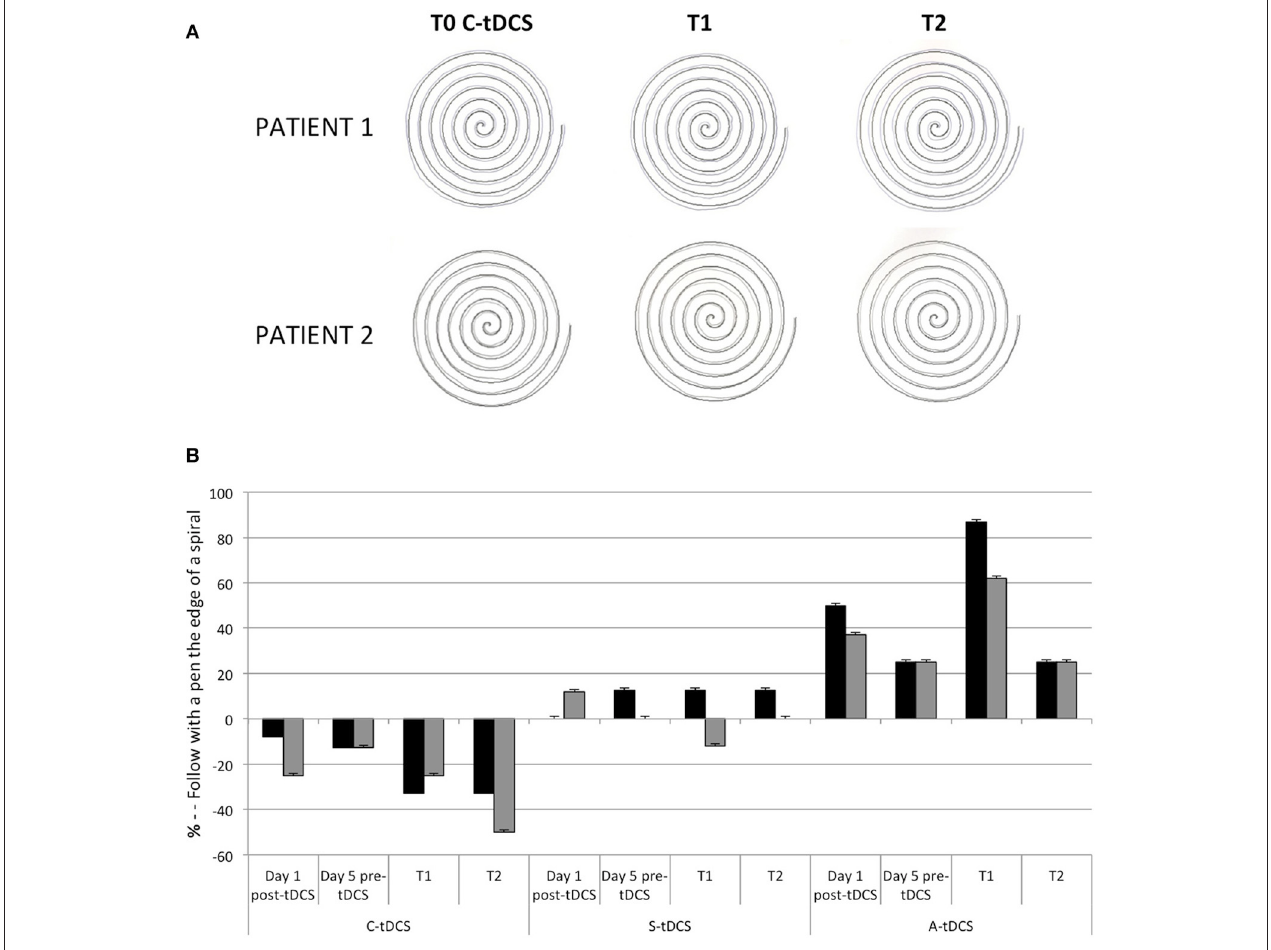
FIGURE 3 | (A) Follow with a pen the edge of the spiral at pre (T0) and post C-tDCS (T1 and T2) in both patients. (B) The histogram showed the qualitative analysis in the percentage differences after tDCS in both patients. 0% is baseline